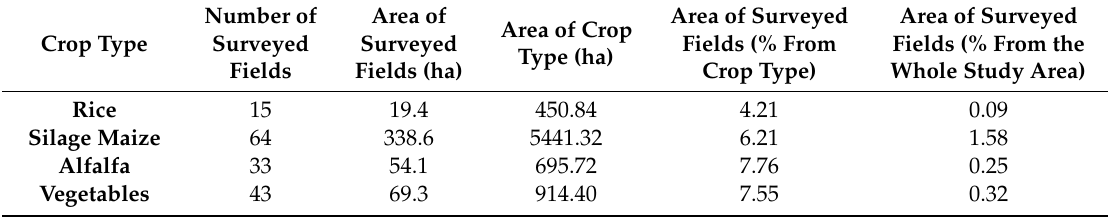
Figure 2. Satellite image acquisition date and phenology of di ff erent crop types in the study area. Rice has been transplanted and is not at the emergence stage. The time between sowing and harvest stages for vegetables and alfalfa is 40–50 days and again they grow and harvest. Table 1. Number and area of surveyed fields in each crop type class per training and validation